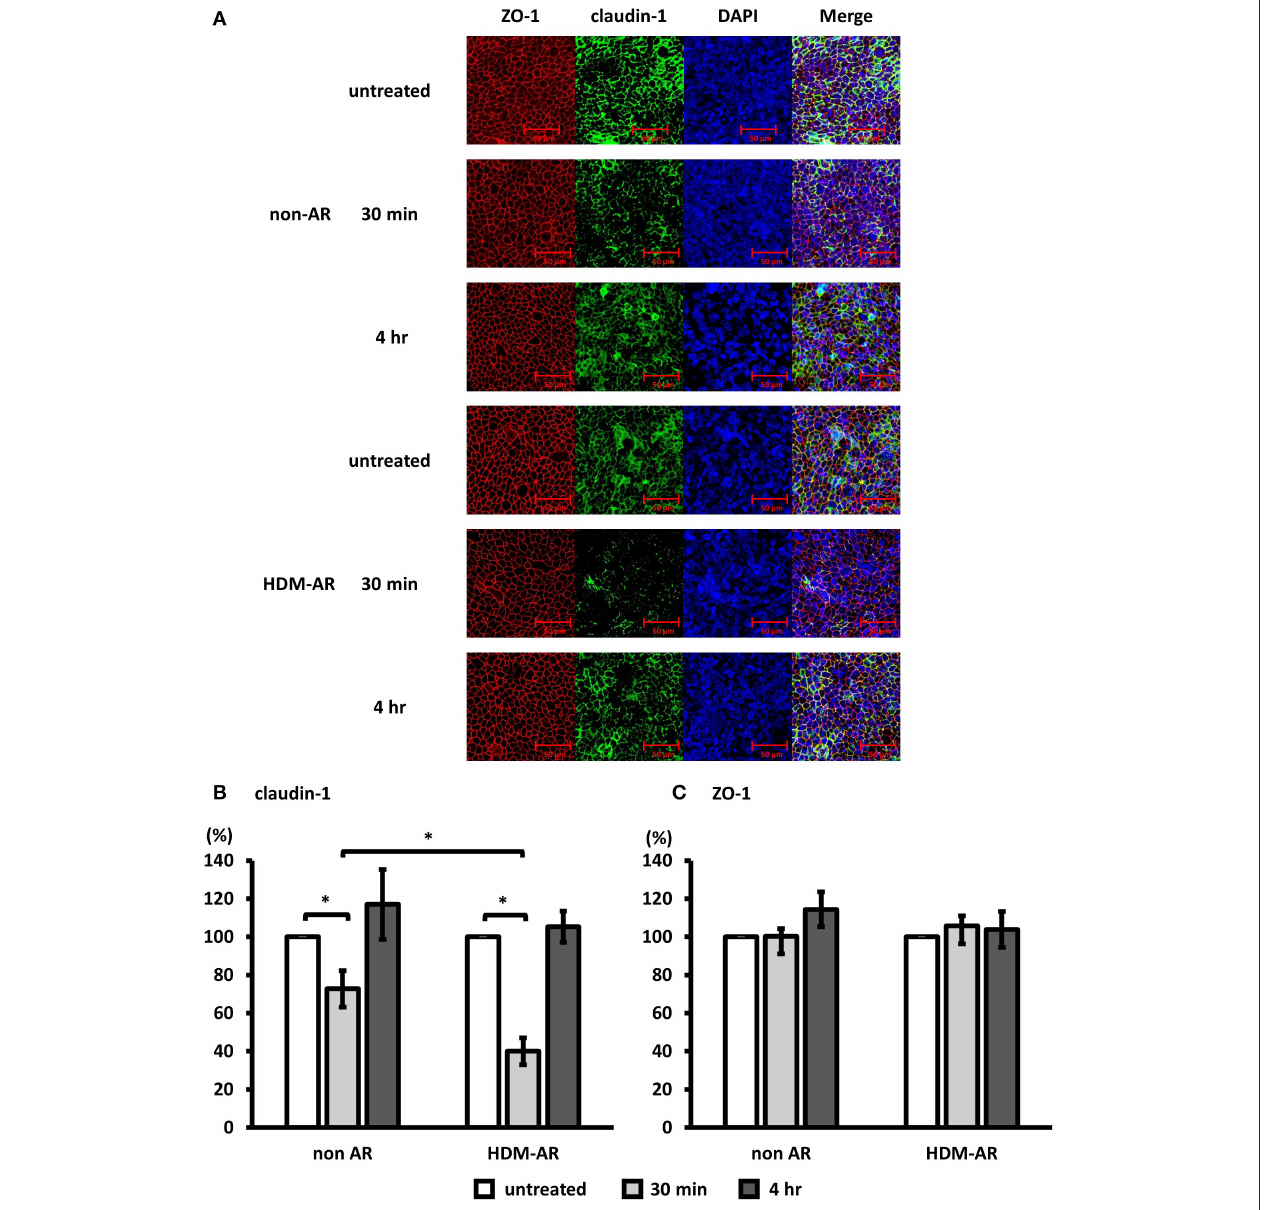
FIGURE 3 | Der p 1 disrupted claudin-1 expression transiently in HNEC-ALI cultures. Representative immunofluorescence images of HNEC-ALI cells from non-AR patients and HDM-AR patients double stained with claudin-1 (A,B) and ZO-1 (A,C) antibodies after challenge with PBS (untreated) or 4mM Der p 1 for 30min and 4h. Red, ZO-1; green, claudin-1; blue, DAPI. Magnification is 20 × (A) . Fluorescence intensity of claudin-1 (B) and ZO-1 (C) expression normalized with DAPI after 30min and 4h exposure with or without 4mM Der p 1. The data is shown as the means ± SEM. ( n = 4; respectively for each group). * p < 0.05, one-way ANOVA followed by Dunnett’s